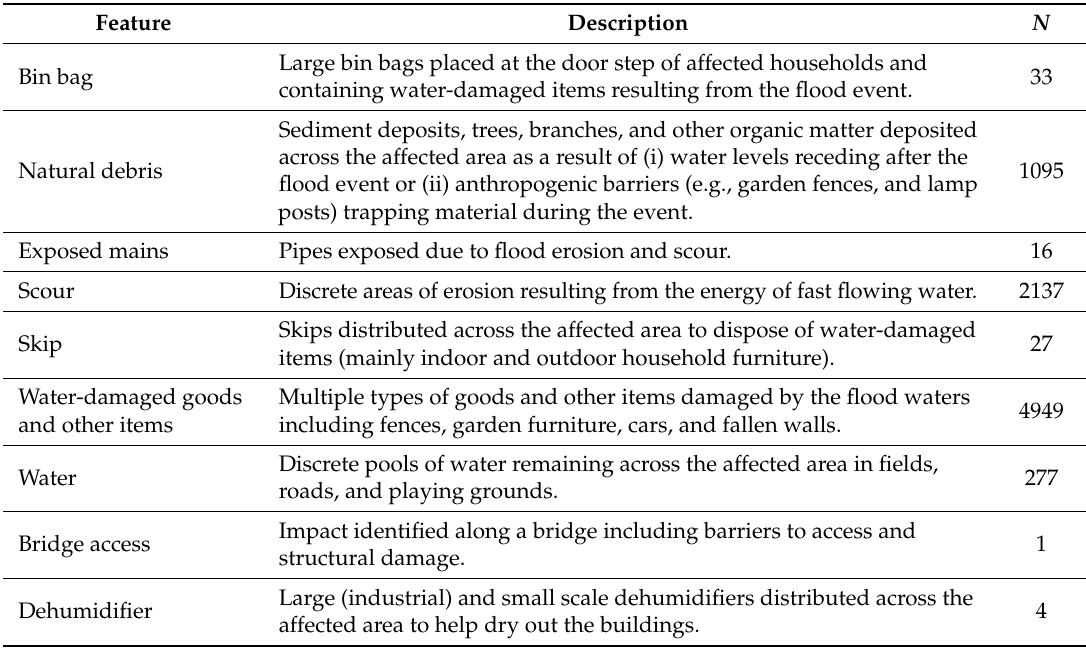
Table 1. Flood impact features identified in the high-resolution aerial imagery collected with the Sirius-Pro (Topcon Positioning System Inc., Livermore, CA, USA) unmanned aerial vehicle (UAV) in Cockermouth, Cumbria, UK (13 December 2015) after the Desmond storm. A total of 8539 impact points were identified. N stands for the number of times a specific feature was